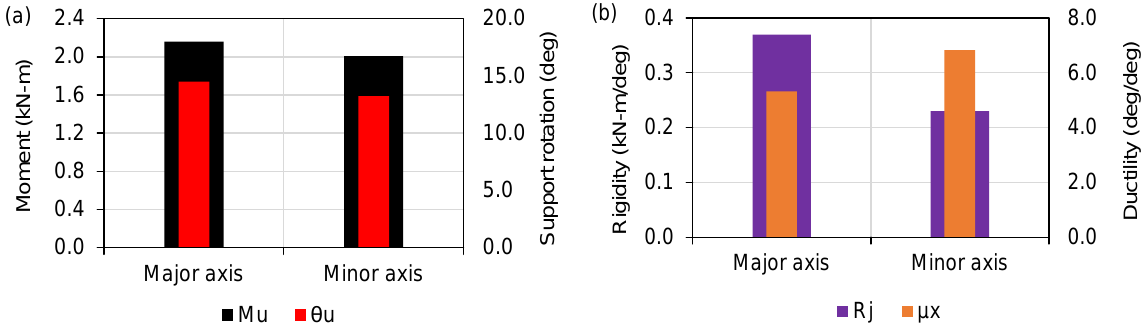
Figure 13. Performance indicators including ( a ) moment and rotation relationship and ( b ) rotational rigidity and ductility behaviour of the bolted steel spline connections tested along the major and minor axes.